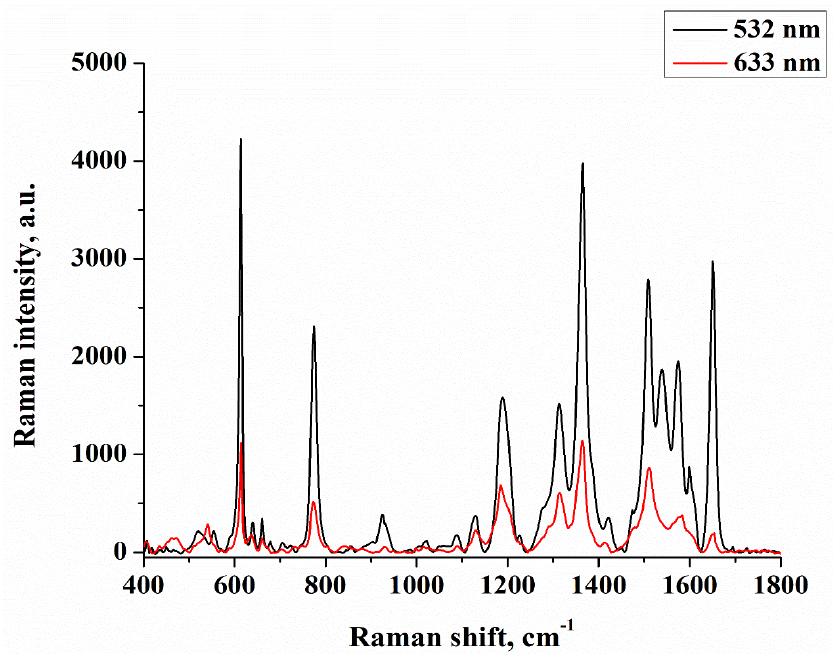
Figure 5. Surfaced-enhanced Raman signal of rhodamine 6G measured with two excitation wave-